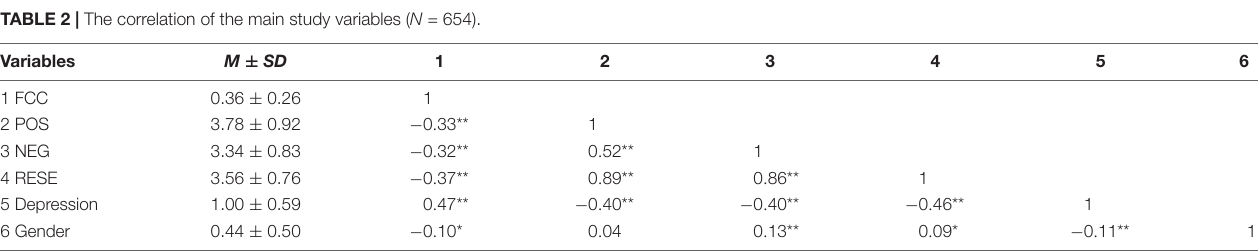
TABLE 2 | The correlation of the main study variables ( N = 654).